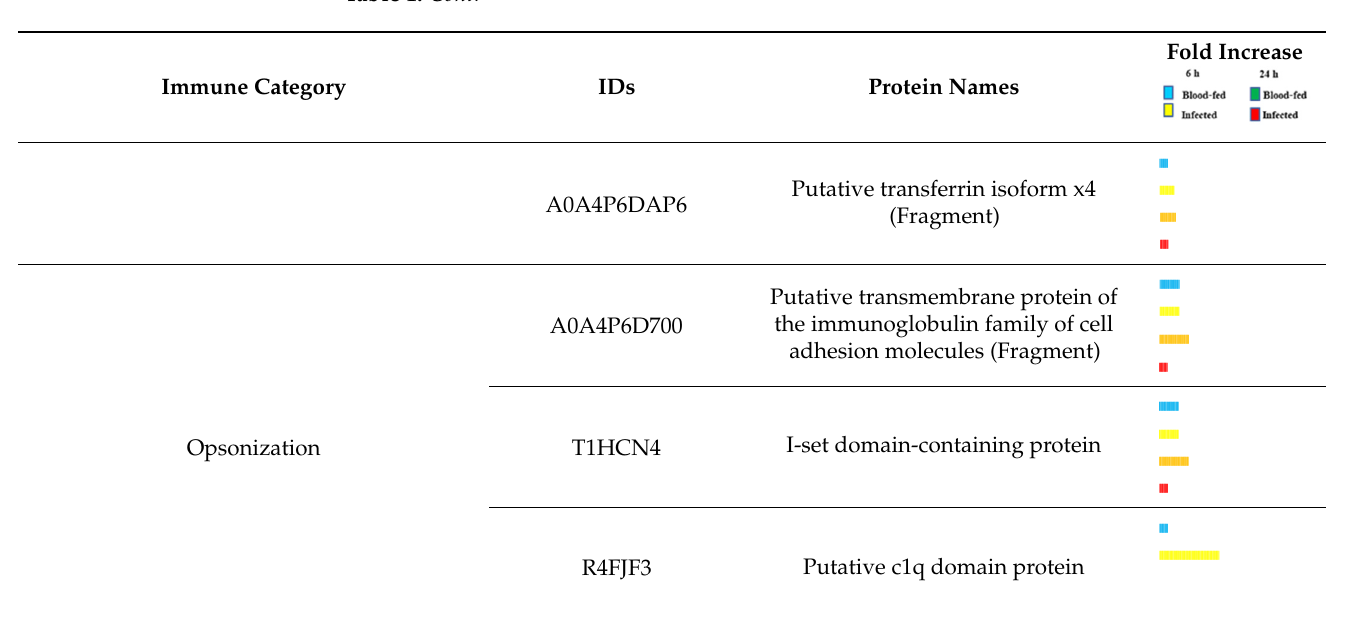
Table 1. Expression pattern of immunity related proteins identified in R. prolixus